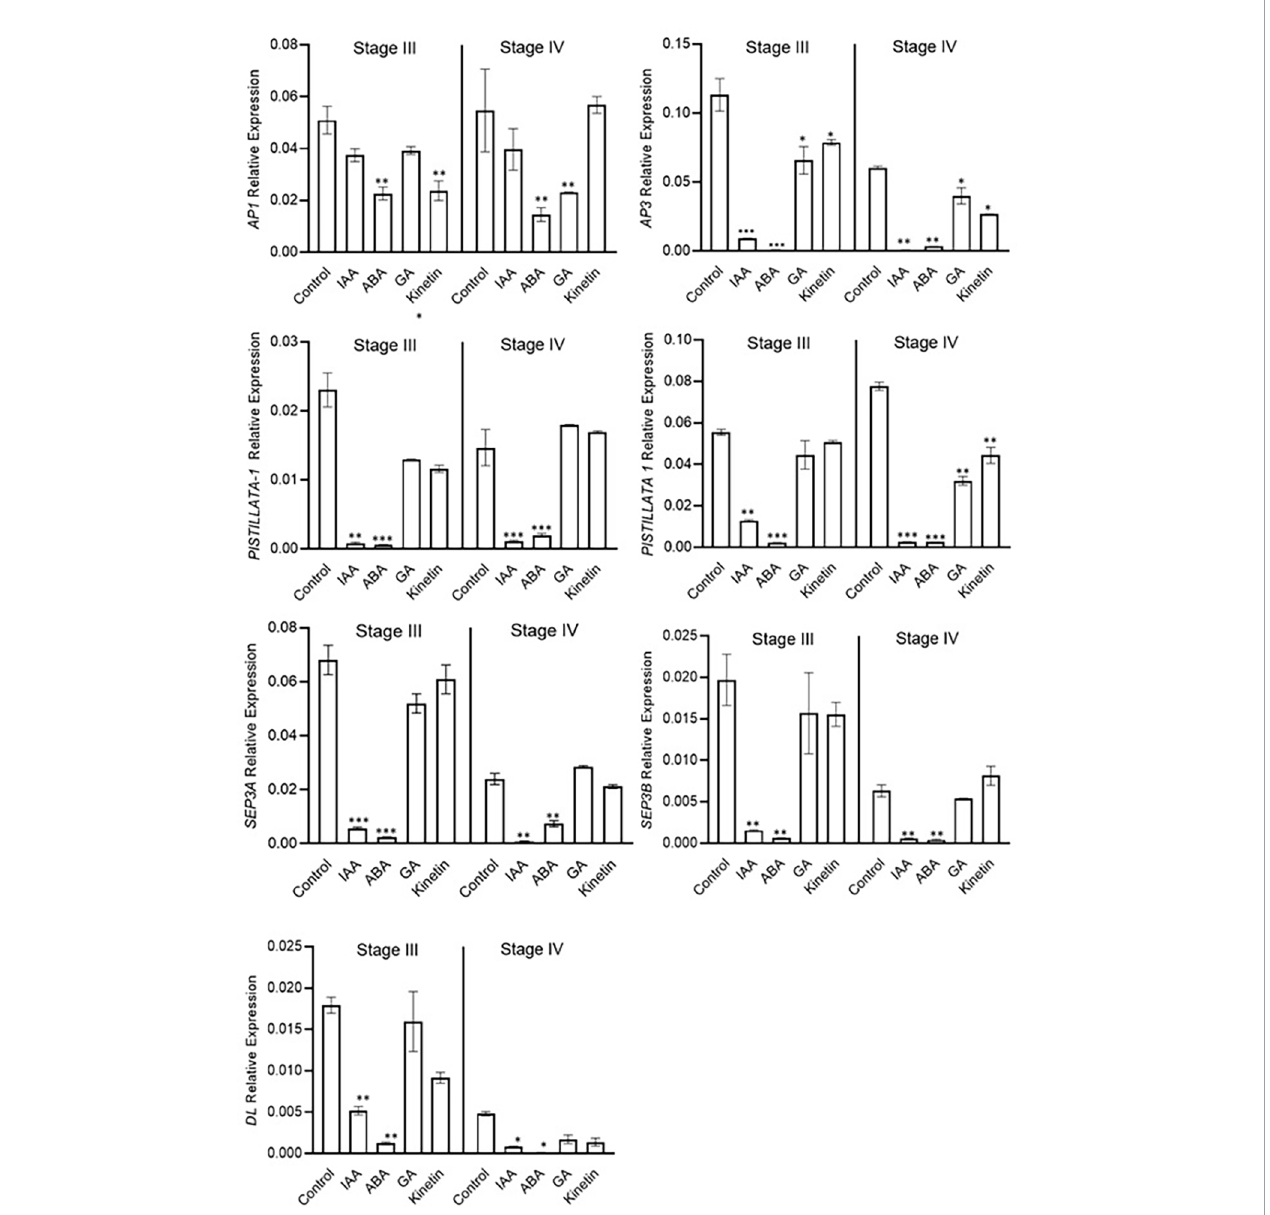
FIGURE 7 Expression pro fi ling of genes involved in fl ower formation after the hormone treatment. Corms already initiated fl owering were used for the treatment. The apical bud samples were collected after 45 and 90 days after the hormonal treatment. Error bars represent ± SD of three biological replicates. Stage III morphologically represents the stamen and stigma elongation stage, and stage IV represents the tepal formation stage. Data represented is mean of three biological replicates. Error bars represent standard error (SE), * indicates P < 0.05, ** indicates P < 0.01, *** indicates P < 0.001 with respect to control (Student ’ s